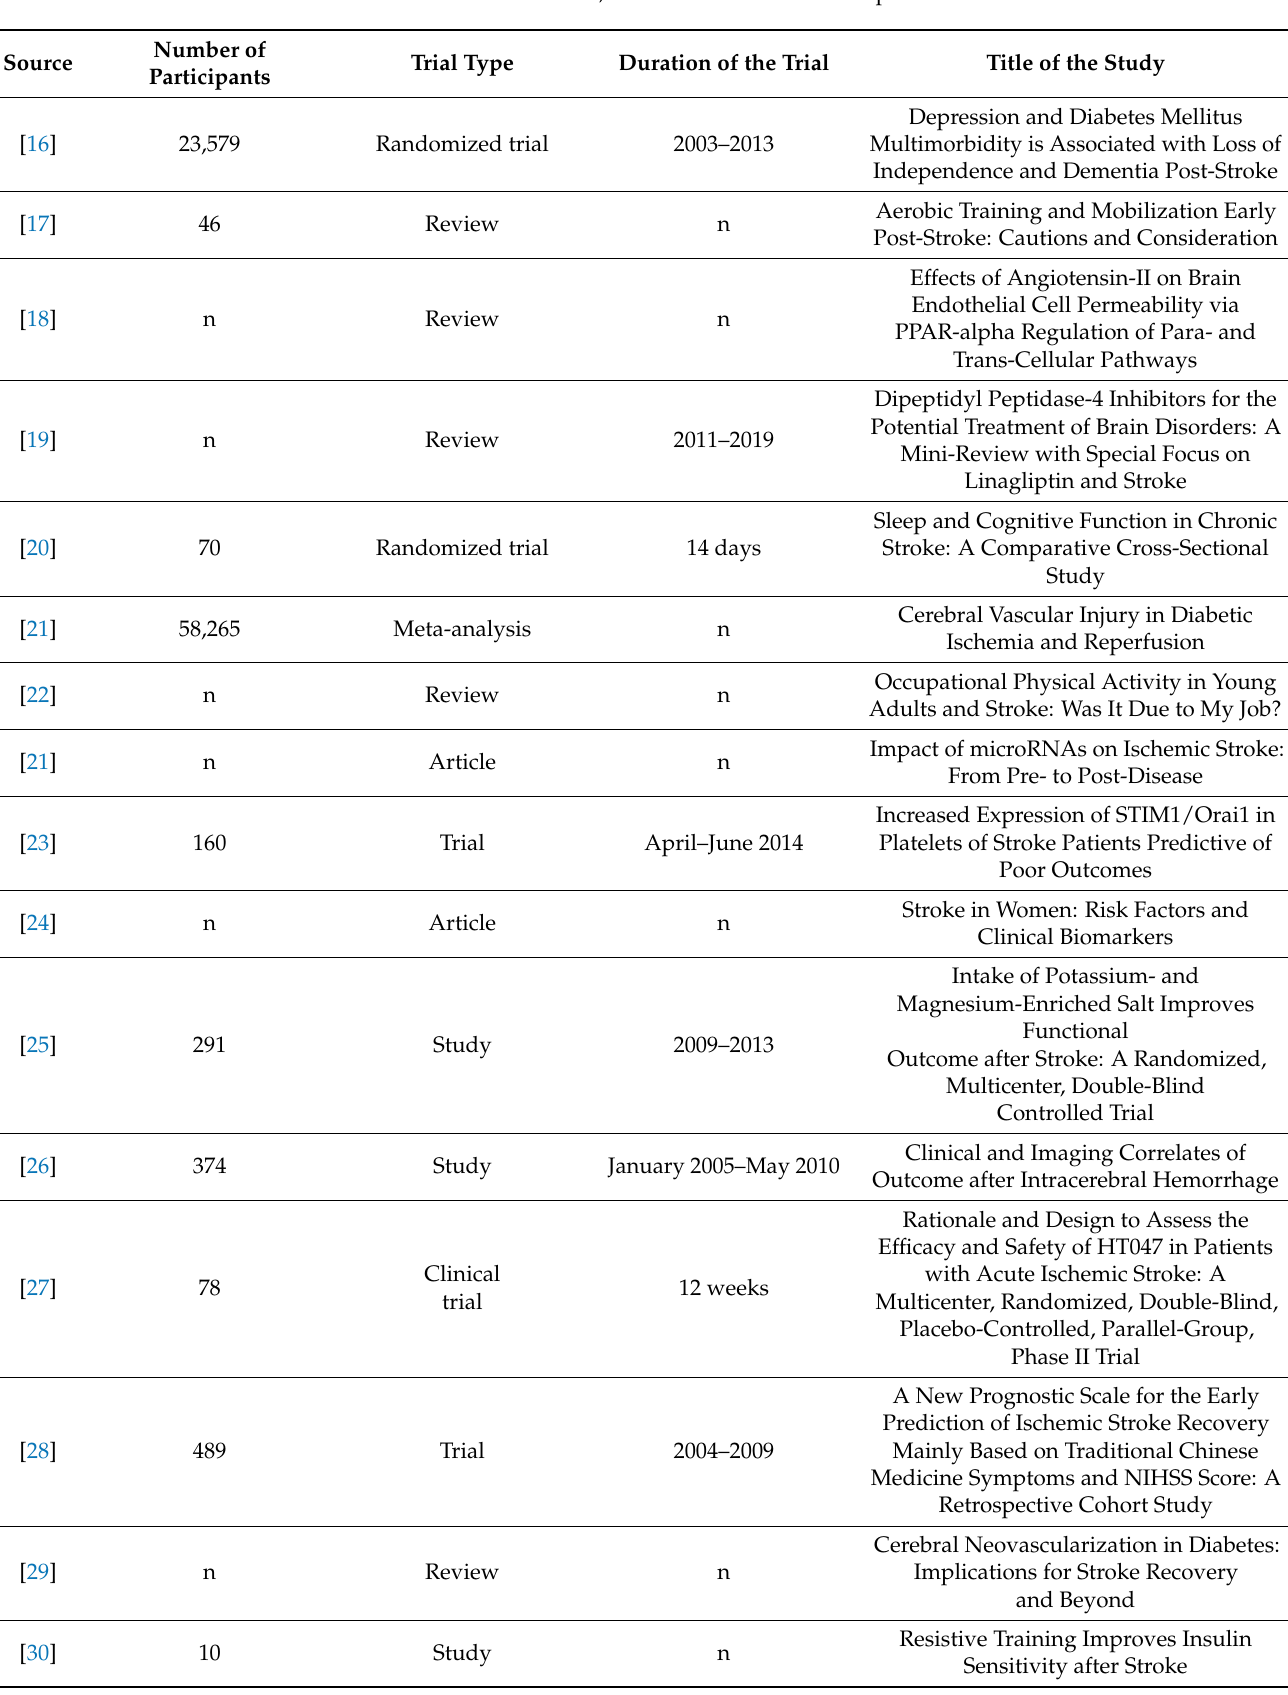
Table 2. Studies and reviews, literature articles. n = not